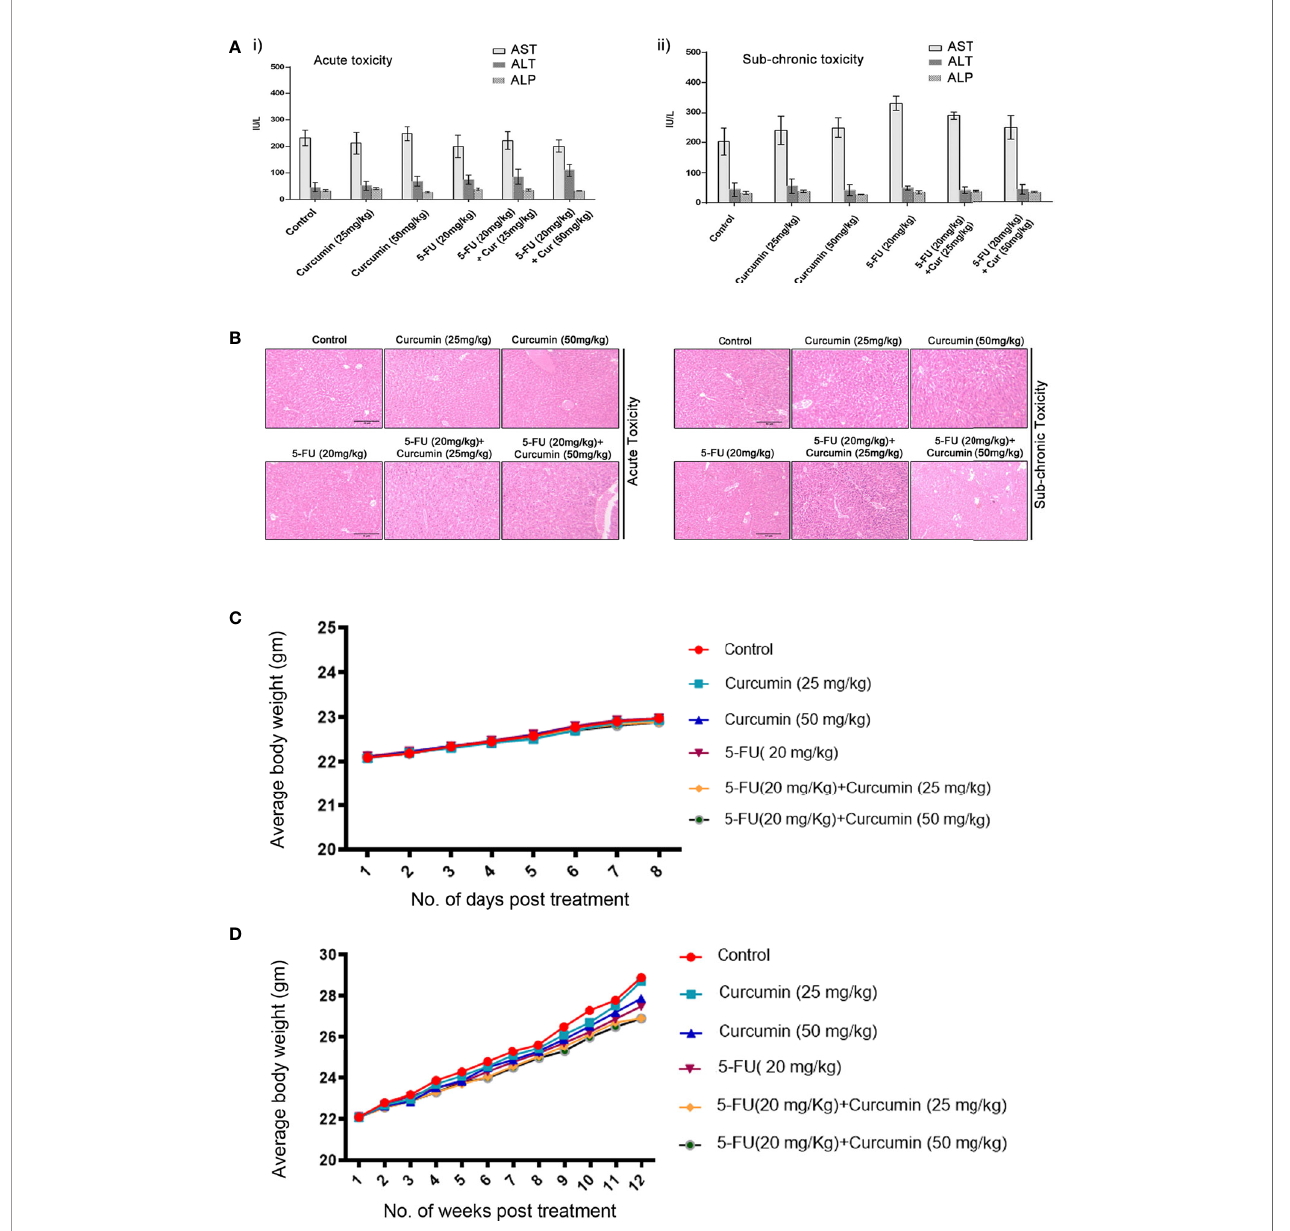
FIGURE 1 | Toxicological analyses of curcumin and 5-FU alone or in combination using Swiss albino mice. [ A (i, ii)]. Curcumin and 5-FU alone and/or in combination at the given dose, does not induce any liver cytotoxicity in both acute and sub-chronic toxicity models as assessed by biochemical analysis. i) Serum levels of AST, ALT and ALP in acute toxicity study. ii) Serum levels of AST, ALT and ALP in sub-chronic toxicity study. (B) Histopathological analysis of liver tissues from acute and sub-chronic toxicity study. (C) The average body weight of animals in different groups during the acute toxicity study. (D) The average body weight of animals in different groups during the sub-chronic toxicity